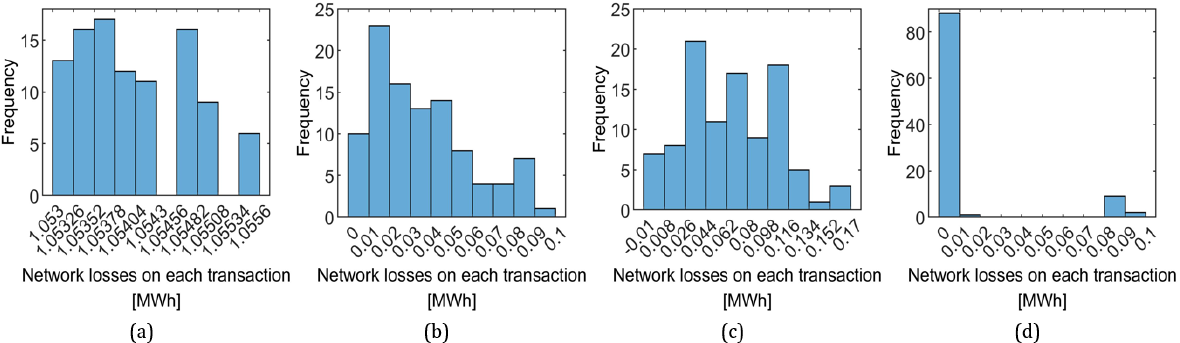
Figure 12. Histograms of network losses of selected transaction numbers in 100 trials of the guided case simulations with the IEEE 39 bus case and the transaction limit 50 MWh: ( a ) network losses of the #1 transactions in 100 trials; ( b ) network losses of the #200 transactions in 100 trials; ( c ) network losses of the #400 transactions in 100 trials; ( d ) network losses of the #600 transactions in 100 trials.